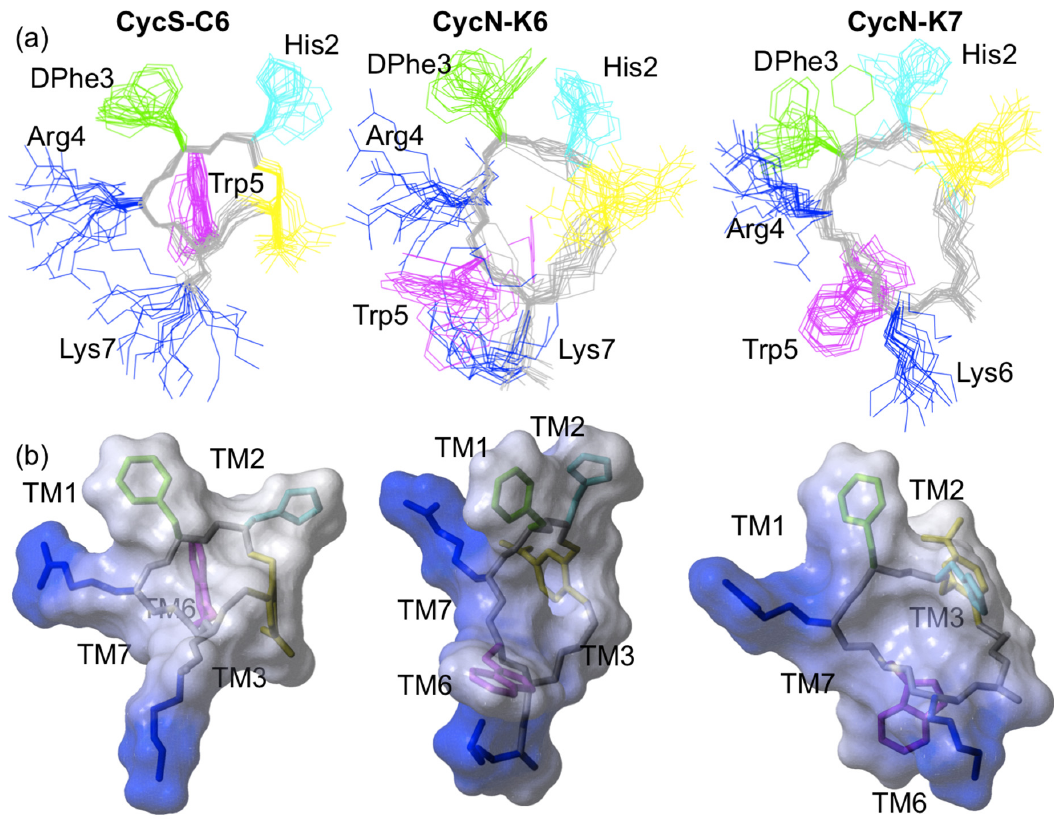
Figure 4. 3D NMR structures of peptides CycS-C6 [20], CycN-K6 and CycN-K7 . ( a ) Ensemble of the 20 lowest target function calculated structures. Side chains are colored in cyan for His, green for DPhe, magenta for Trp, and blue for Arg and Lys. Backbone atoms are displayed in grey and the thioaryl-bridge in yellow. ( b ) Electrostatic surface of a representative conformer of each peptide overlaid onto the corresponding structure. Blue color indicates positively-charged areas. The MC1R transmembrane helices (TM1, TM2, TM3, TM6 and TM7), which are close to the essential peptide side chains (His, DPhe, Arg and Trp) in the reported MC1R/peptide model [24], are indicated. In the represented views, TM6 and TM3 lie behind CysS-C6 and CycN-K7 , respectively.